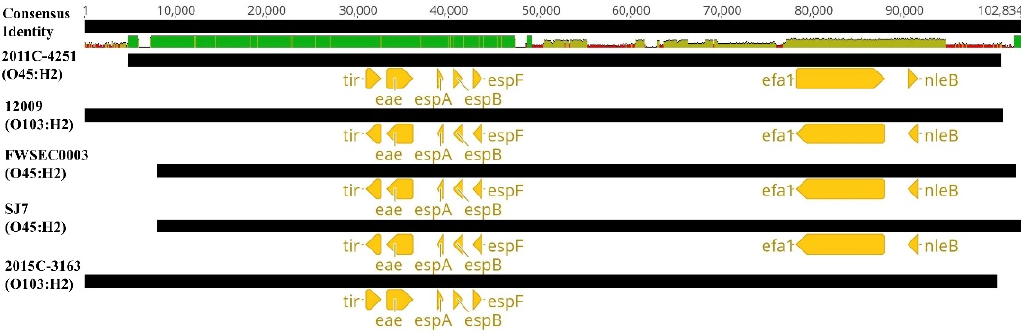
Figure 5. Nucleotide sequence alignments of the locus of enterocyte effacement (LEE) pathogenicity islands from the genomes of three clinical STEC O45:H2 strains (SJ7 (sequenced in this study), FWSEC003, and 2011C-4251), and two clinical STEC O103:H2 strains (12009 and 2015C-3163) using the MAFFT algorithm. The consensus identity of the alignment of five LEE pathogenicity islands indicates the mean pairwise nucleotide sequence identified for all pairs in the column: green = 100% identity; green-brown = <100% but >30% identity; and red = <30% identity. Virulence genes within the sequence of each LEE pathogenicity island (black ) are annotated and colored ( yellow ).